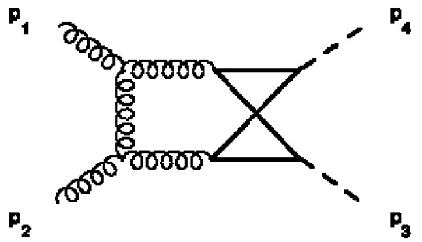
Figure 16. Non-planar ( HH